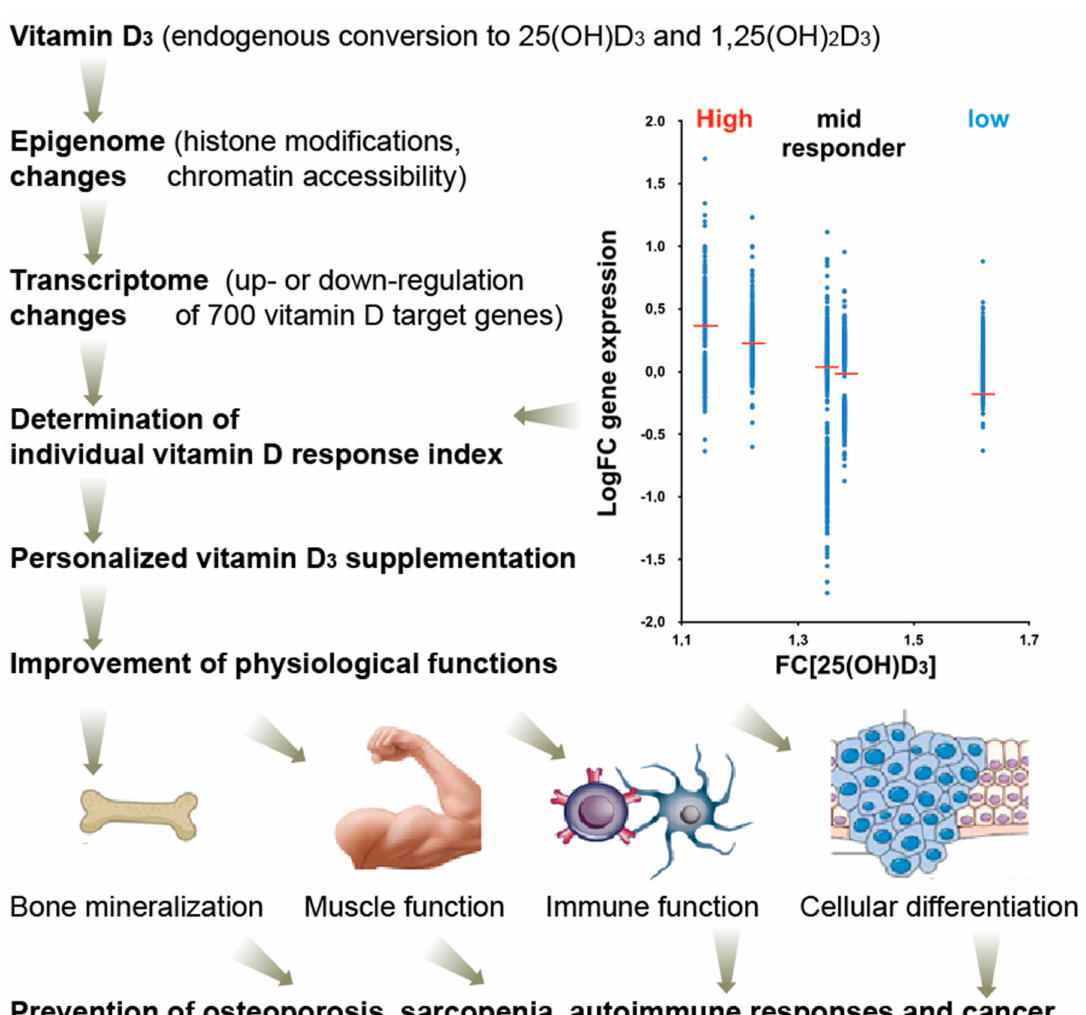
Figure 4. Clinical benefits of optimized vitamin D action. The vitamin D response index segregates individuals into high, mid, and low vitamin D responders and allows a more accurate monitoring of vitamin D effects in clinical setups, such as a prevention of osteoporosis, sarcopenia, autoimmune diseases, and possibly even cancer. The index is based on individual’s genetic and epigenetic status, but does not depend on their vitamin D status. It is determined primarily via changes of the transcriptome (i.e., mRNA transcription of vitamin D target genes) of vitamin D responding tissues, such as PBMCs. FC, fold